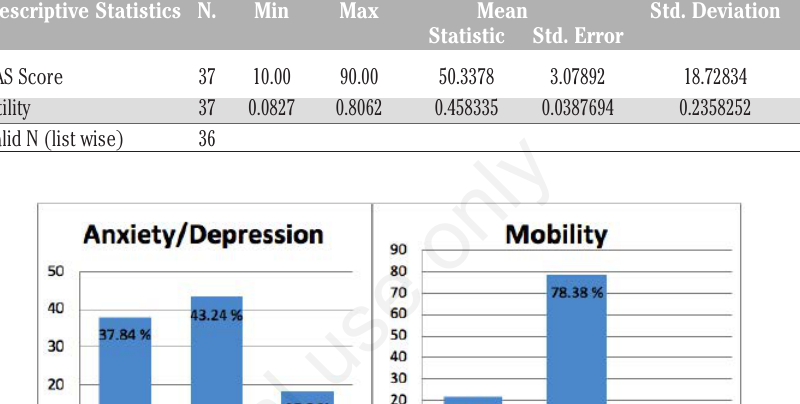
Table 2. EQ-5D Index and Visual Analogue Scale (VAS) Scores. Descriptive Statistics N.